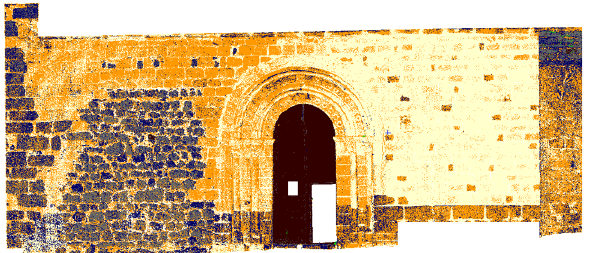
Figure 5. FARO Focus 3D map for the 6–classes unsupervised classification.